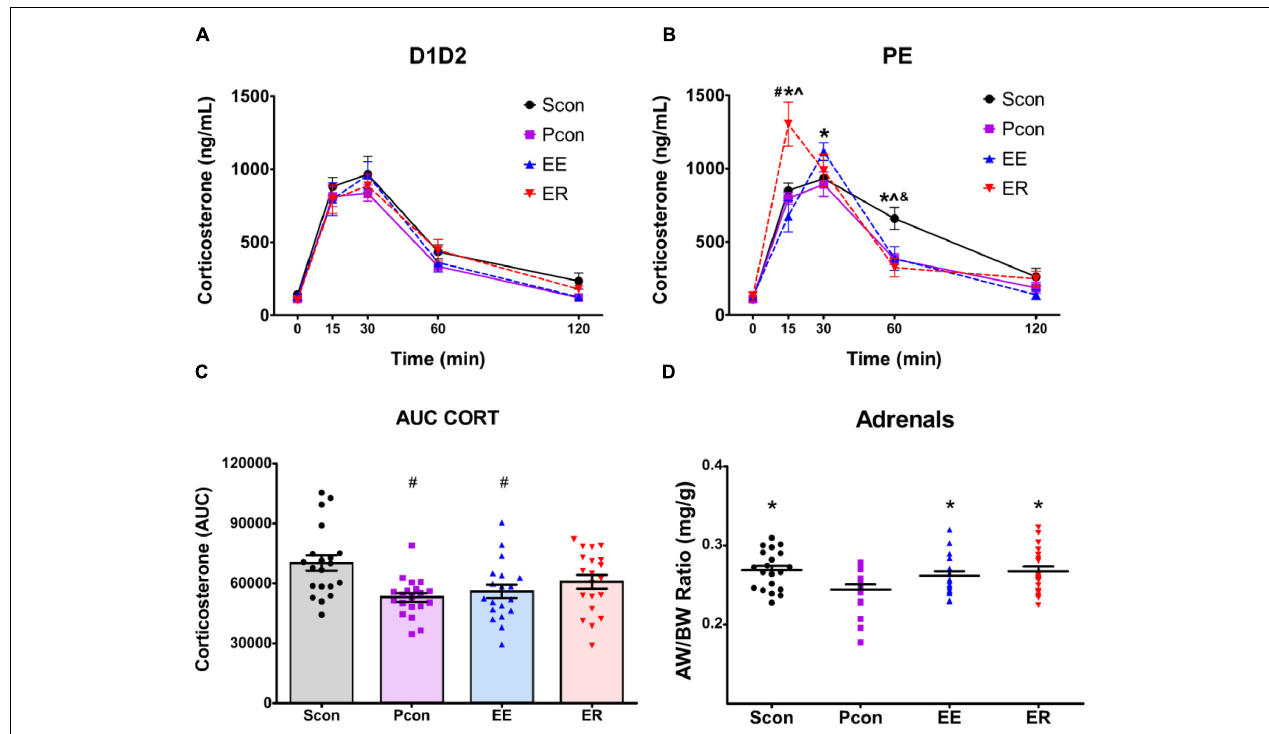
FIGURE 2 | Single-housing (SCon), enrichment (EE), and enrichment removal (ER) in females causes a dysregulation of the HPA axis response to acute restraint stress in a cycle dependent manner and increases adrenal size. Although hormonal time course data for all groups were analyzed by three-way repeated-measures ANOVA (see text), the time profiles of D1D2 and PE animals are shown separately for visual clarity of treatment effects. (A) No effects of housing manipulations on stress-induced corticosterone levels were observed for females in the D1D2 stage of the estrous cycle. (B) For females in the PE stage of estrous cycle, ER animals have increased corticosterone at 15 min after the start of restraint, EE animals have increased corticosterone at 30 min after the start of restraint, and Scon animals have increased corticosterone at 60 min after the start of restraint # p < 0.05 vs. Scon, ∗ p < 0.05 vs. Pcon, ∧ p < 0.05 vs. EE, & p < 0.05 vs. ER. (C) Total corticosterone response to restraint is increased in the Scon group ∗ p < 0.05 vs. Pcon, ∧ p < 0.05 vs. EE. (D) Single-housing, enrichment and enrichment removal in females causes adrenal hypertrophy ∗ p < 0.05 vs.